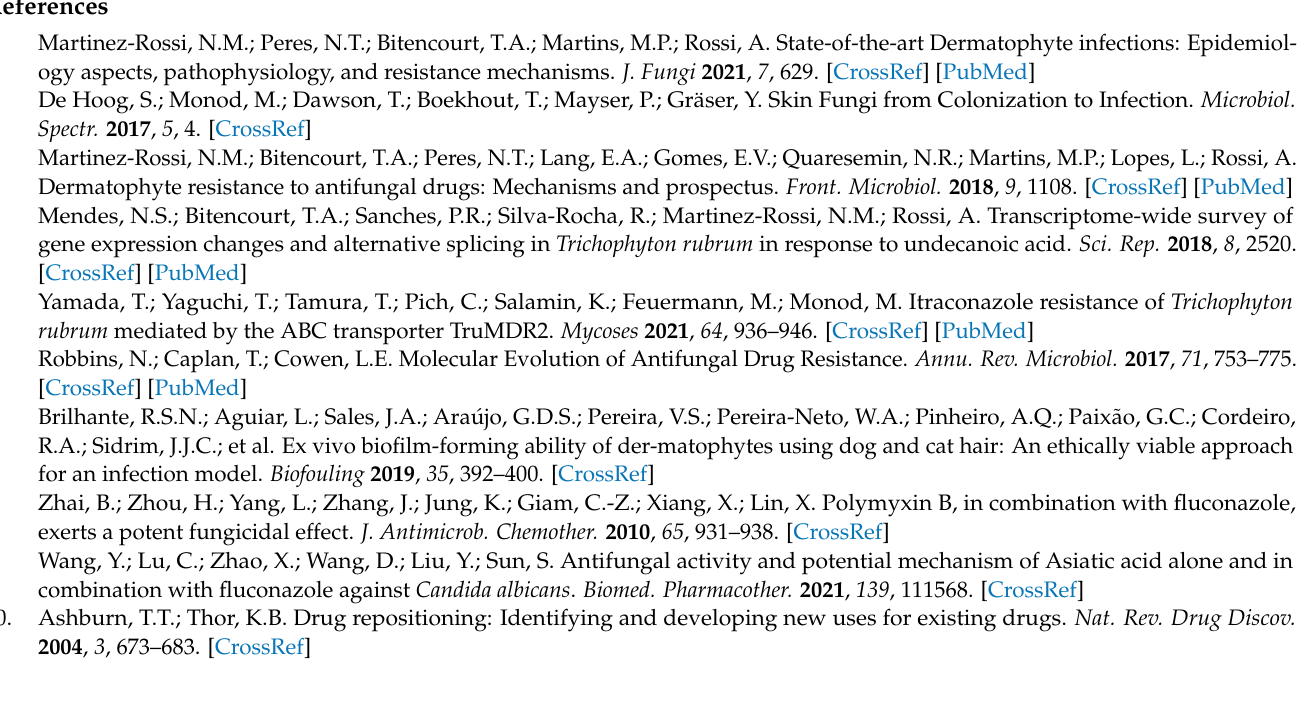
Figure S2. Differentially expressed genes, TERG_00162 (MFS multidrug transporter), TERG_04234 (Hydrophobin), TERG_06755 (C-8 sterol isomerase), and TERG_12319 (Chitin synthase 2),